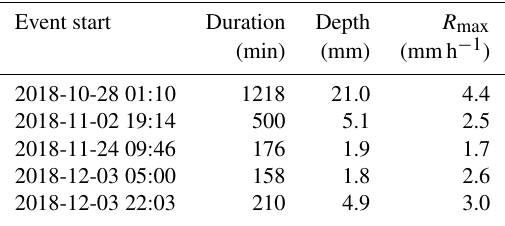
Table 1. CML characteristics in Prague-Haje, Czech Republic. The suffixes “a” and “b” denote sublinks of a CML.